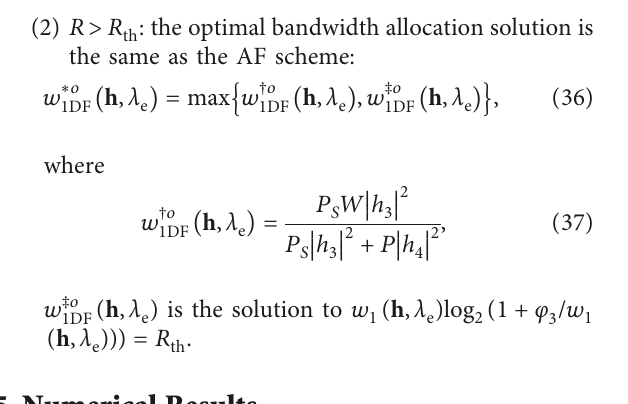
W σ 2 � 1/2, ( d S / 4 0